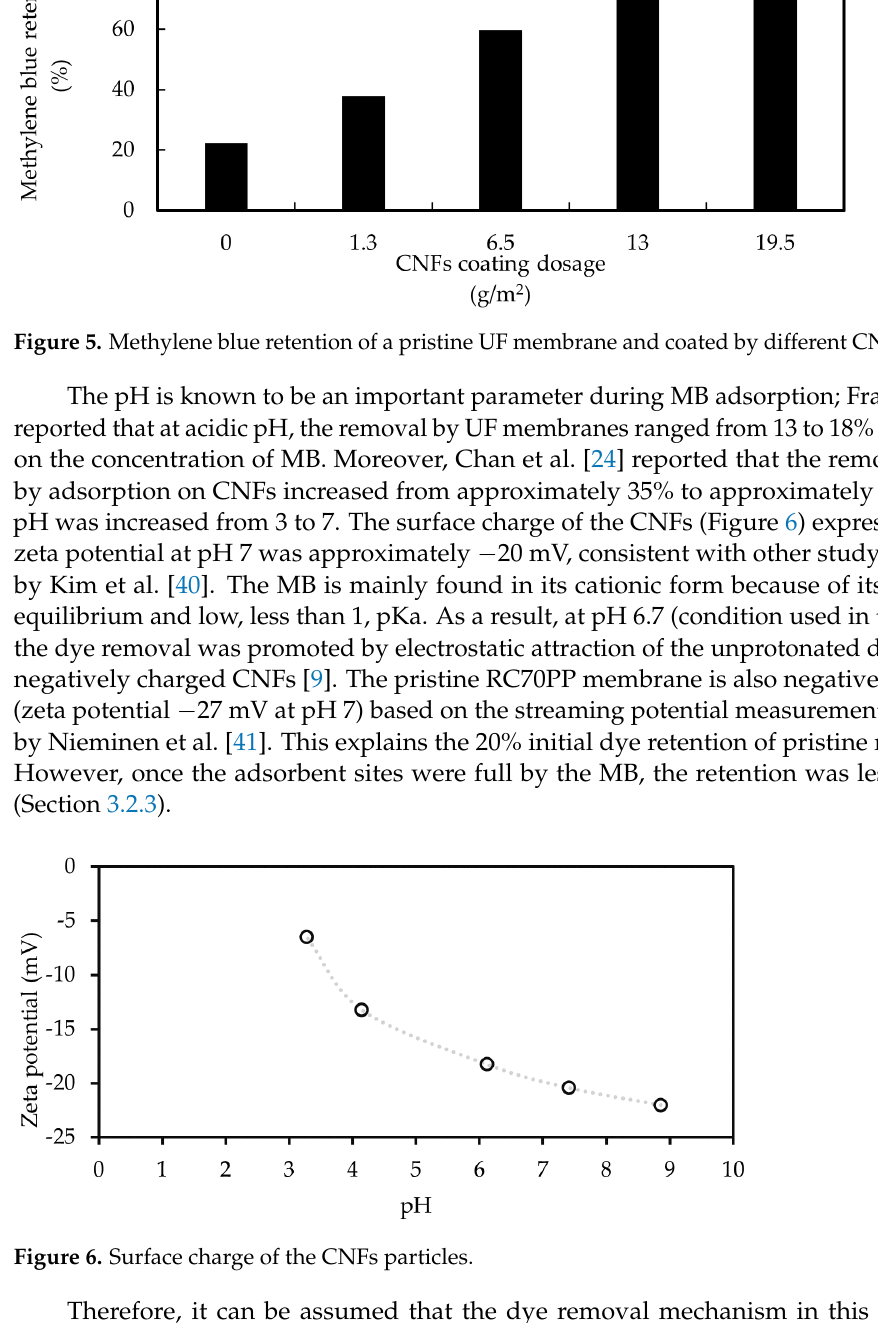
Figure 4. Pure water permeability of pristine and coated UF membranes at different CNFs dos- ages.